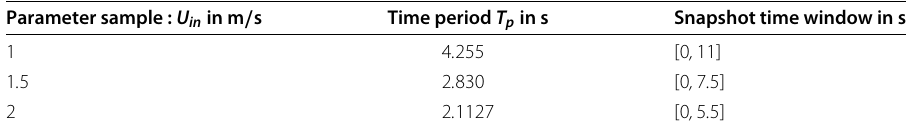
Table 2 Offline parameter samples and the corresponding vortex shedding frequency and snapshots time window Parameter sample : U in in m /